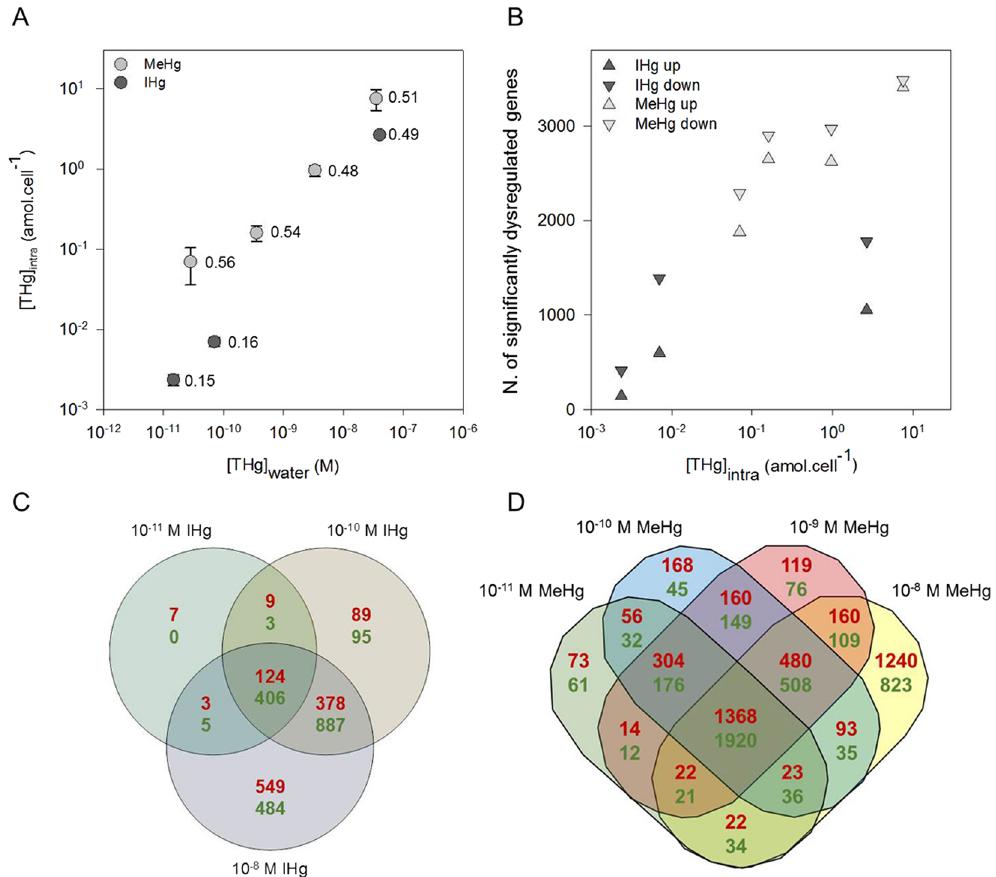
Figure 1. Intracellular total Hg concentrations ([THg] intra , mean ± sd, n = 3) in C. reinhardtii exposed to IHg or MeHg, as a function of initial IHg or MeHg exposure concentration expressed as THg ([THg] water ). Values indicate ratio of [THg] intra to [THg] intra + ads , lines show linear regressions of log 10 values ( A ). Number of significantly up- and down-regulated genes (EdgeR FDR < 0.1%) as a function of [THg] intra ( B ). Venn diagrams showing the number of up- (red, upper numbers) and down- (green, lower numbers) significantly regulated genes in C. reinhardtii after 2 h exposure to IHg ( C ) or MeHg ( D ) (EdgeR, FDR <